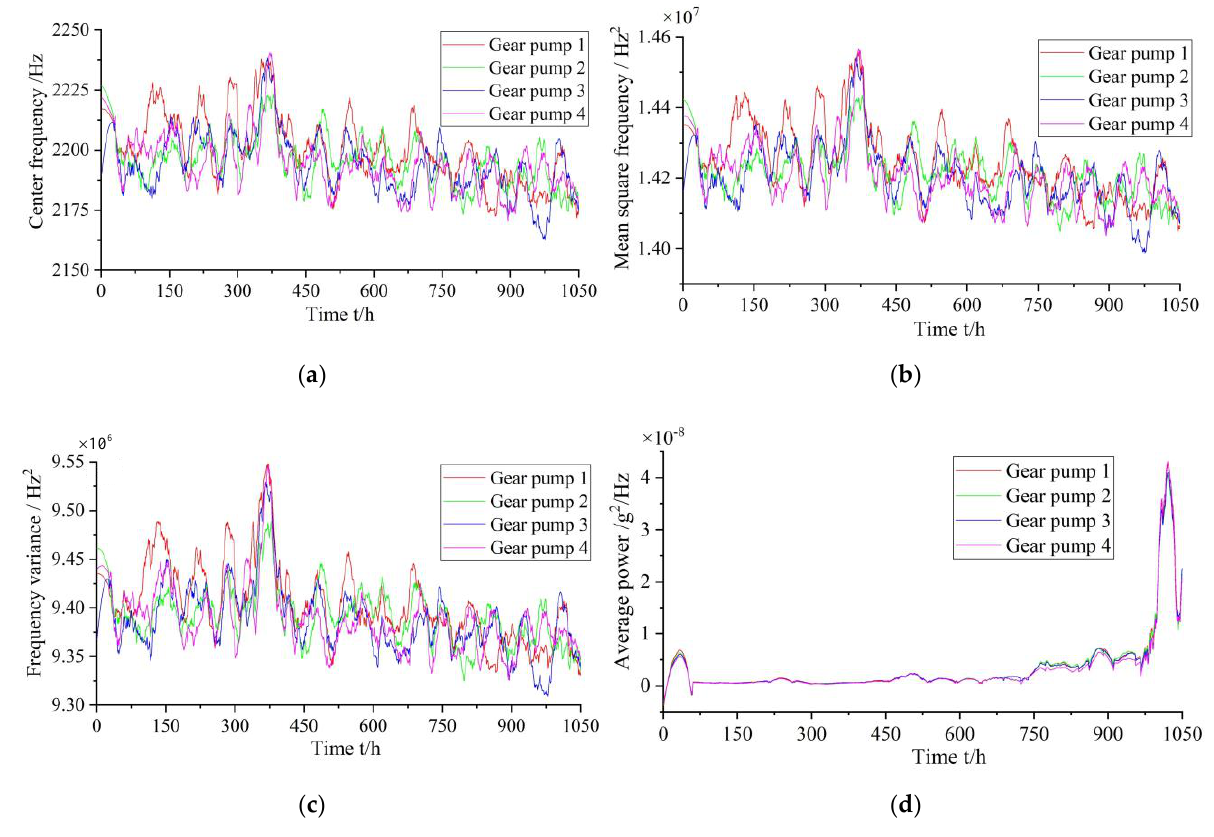
Figure 9. Frequency-domain characteristic parameters: ( a ) Gravity frequency; ( b ) Mean square frequency; ( c ) Frequency variance; and ( d ) Average power.